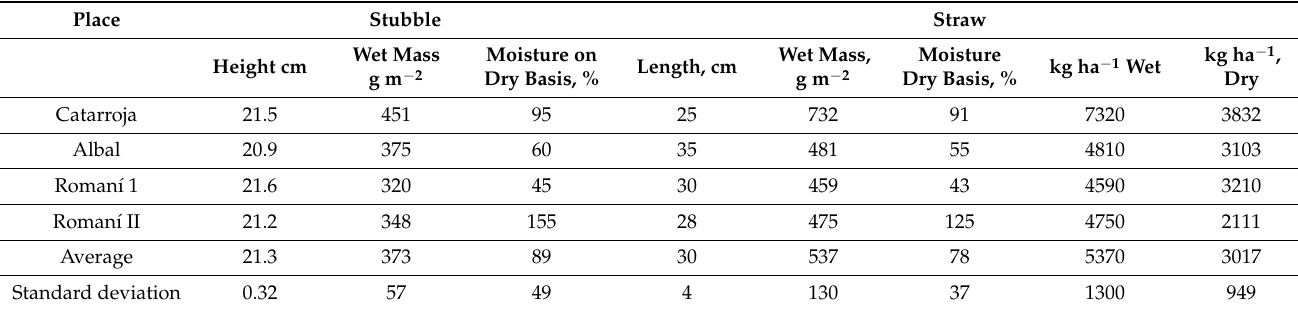
Table 3. Straw and stubble